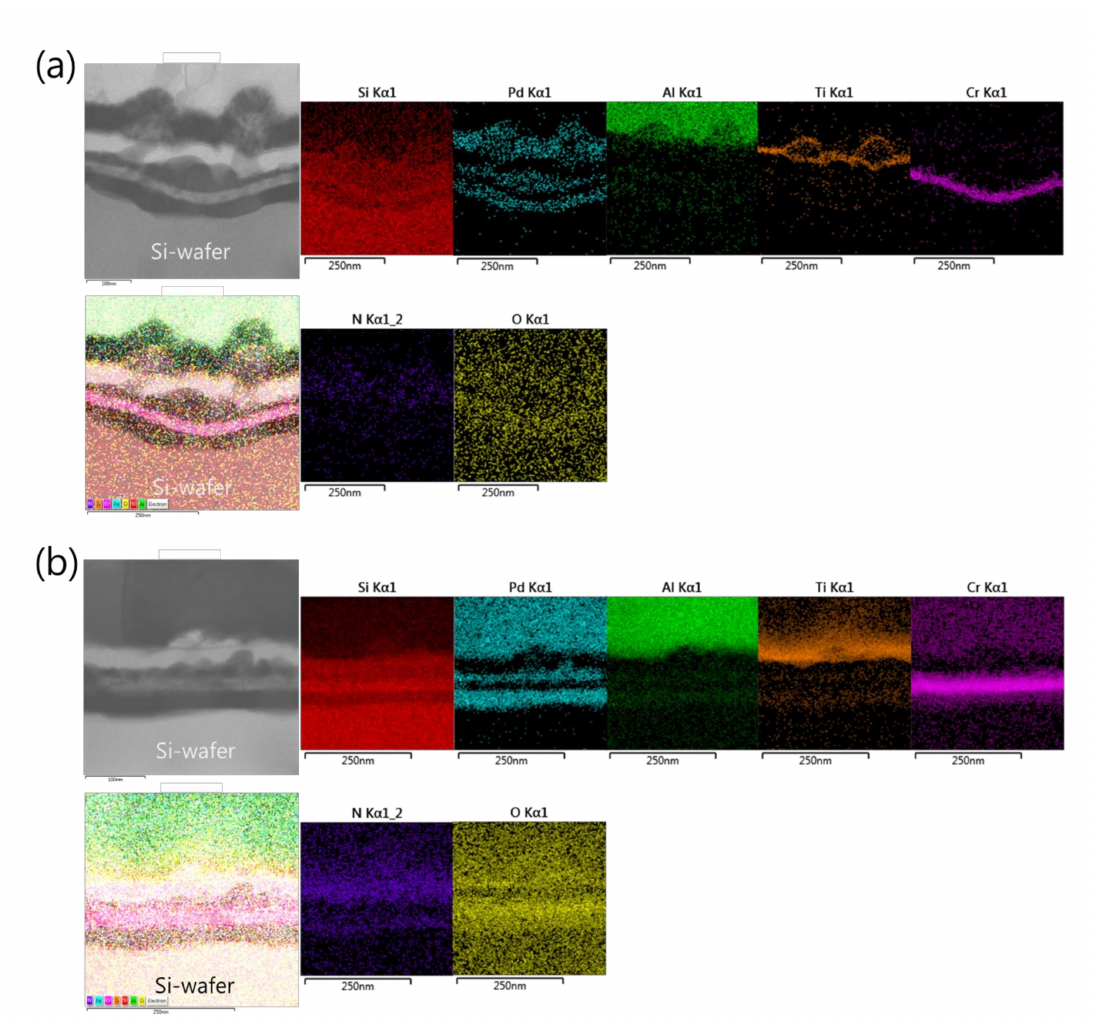
Figure 9. Scanning transmission electron microscope (STEM) images (upper left) and corresponding EDS elemental mappings of the interface structure configuration of the iRMS grown on a PdO x -buffered Si-wafer. ( a ) As-deposited RMS; ( b ) After reaction ignition.